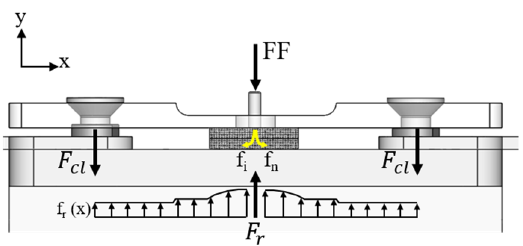
Figure 6. Schematic representation of the forces acting during joint clamping (simplified equilibrium of internal forces).